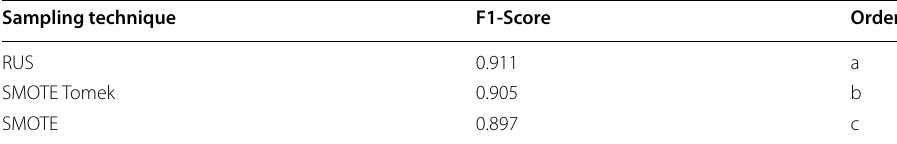
Table 17 Tukey’s HSD results for AUC: sampling